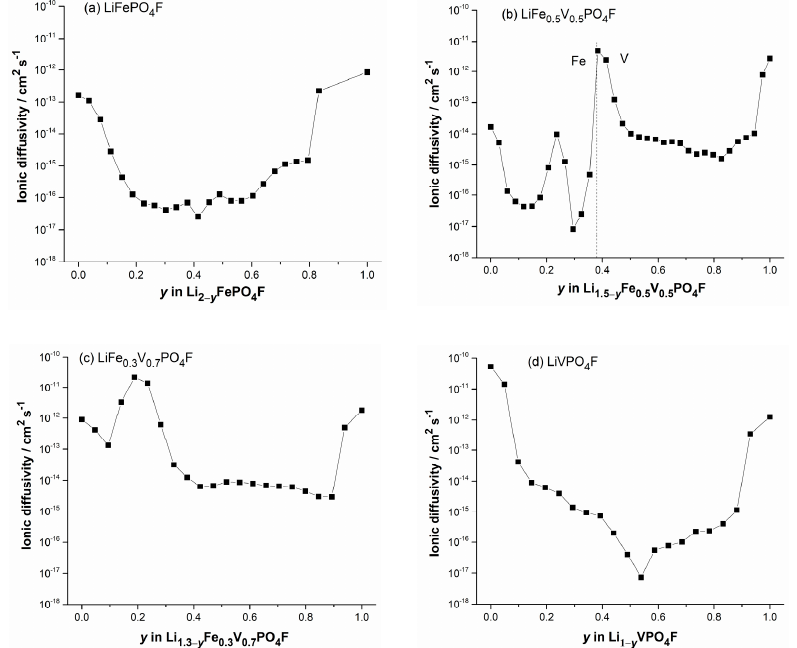
Figure 9. Plots of diffusion coefficients obtained by GITT as a function of Li + -extraction content y in ≤ y ≤ 1) with x = 0 ( a ), x = 0.5 ( b ), x = 0.7 ( c ) and x = 1 ( d III PO Li (cid:2870)(cid:2879)(cid:3051)(cid:2879)(cid:3052) Fe (cid:2869)(cid:2879)(cid:3051) II V (cid:2872) F (0 x